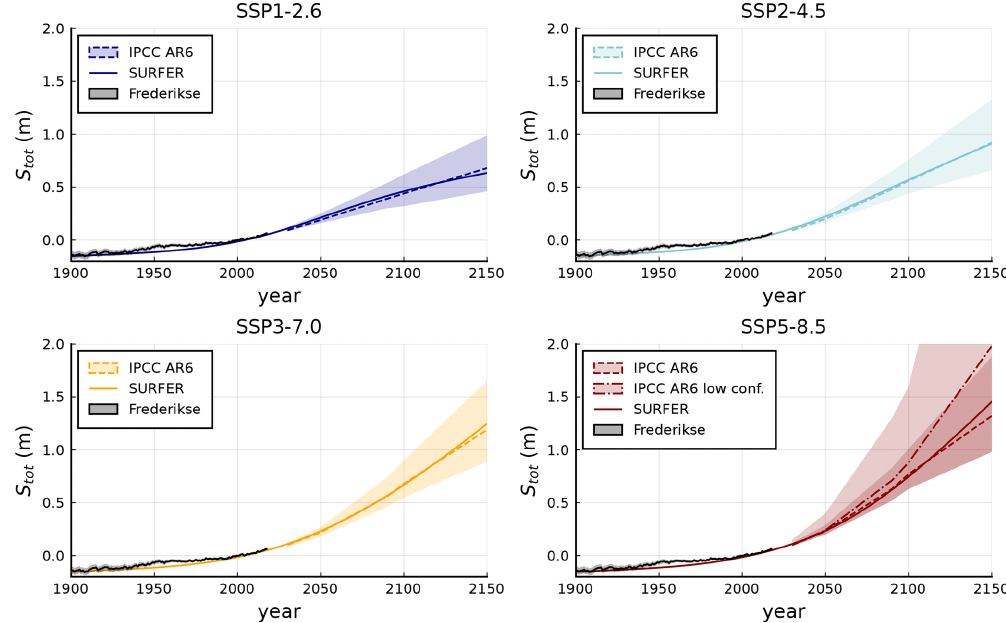
Figure 14. Historic and shorter term sea level rise projections. Solid coloured lines show SURFER’s total sea level rise estimates. Solid black lines with shaded envelope correspond to historic observations reported by Frederikse et al. (2020a), dashed coloured lines correspond to IPCC AR6 estimates and shaded regions to IPCC AR6 likely (medium confidence) ranges. The dash–dot line in SSP5-8.5 corresponds to the low confidence IPCC AR6 estimate. SURFER’s and historical results are with respect to year 2004. IPCC results are relative to a baseline of 1995–2014.